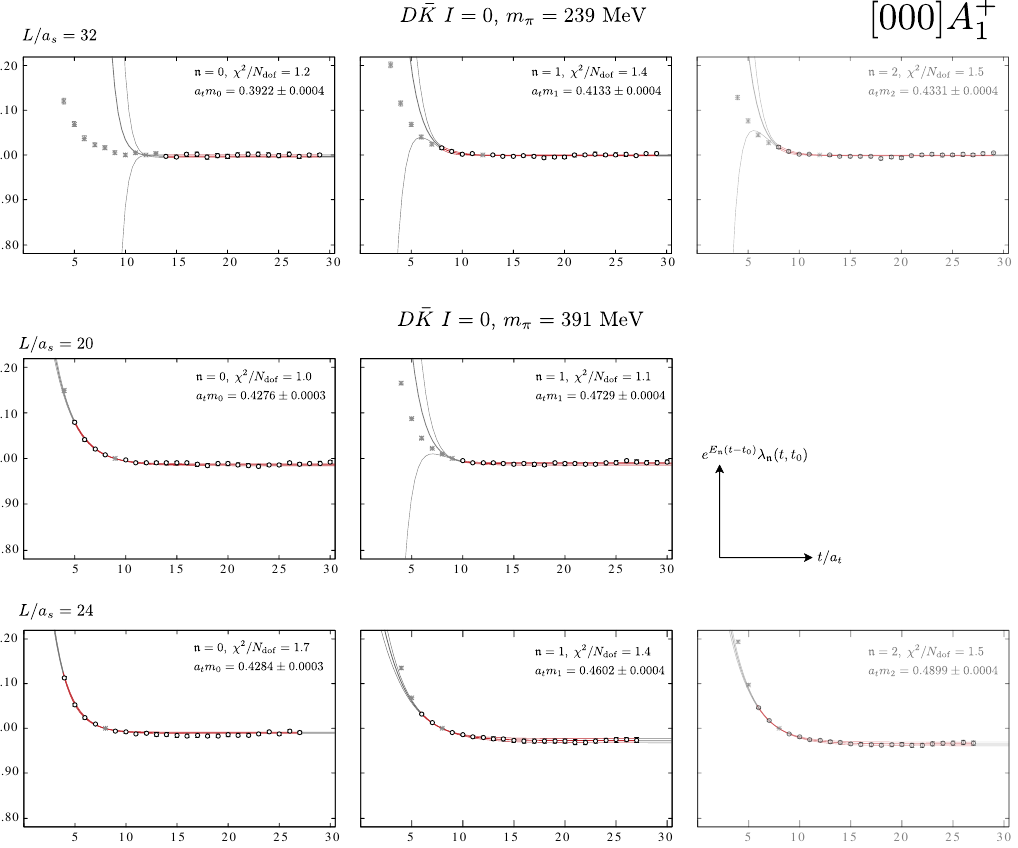
Figure 21 . As figure 20 but for D ¯ K I = 0 . These correspond to levels shown in figures 5 and